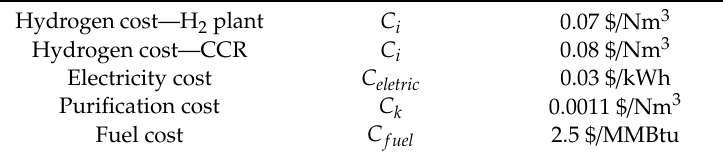
Table 1. Parameters used to calculate the operating